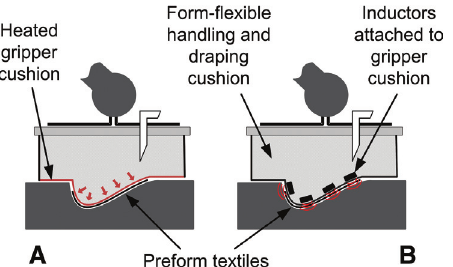
Figure 9 Form-flexible handling device with a heating textile (A) and with inductors on the gripper cushion